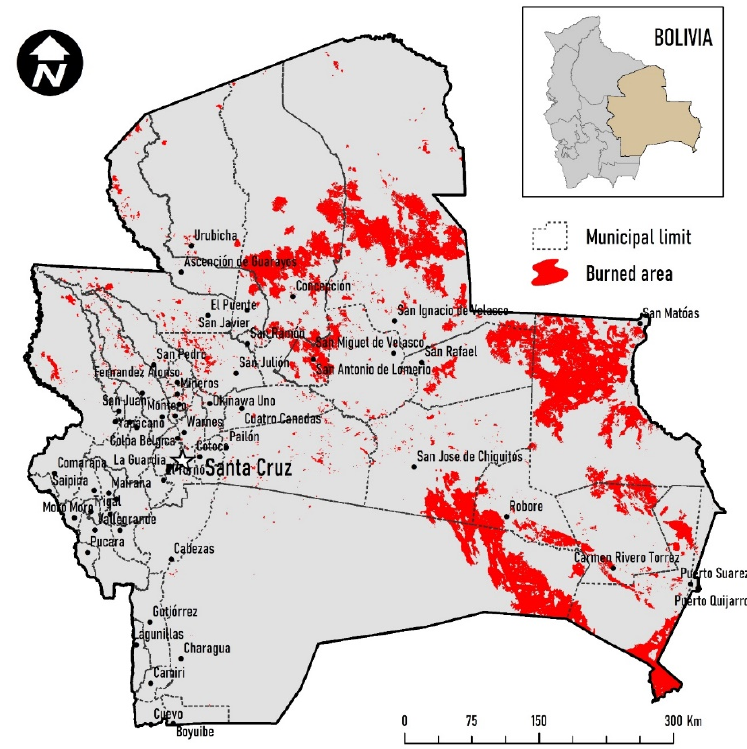
Figure 1. Location of the Department of Santa Cruz, Bolivia and scars from areas burned in 2019.